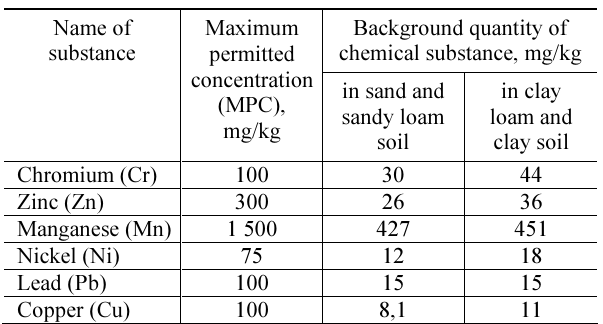
Table 1. MPC of hazardous chemical substances and their background quantities in soil according to Lithuanian Hygiene Norm HN 60:2004